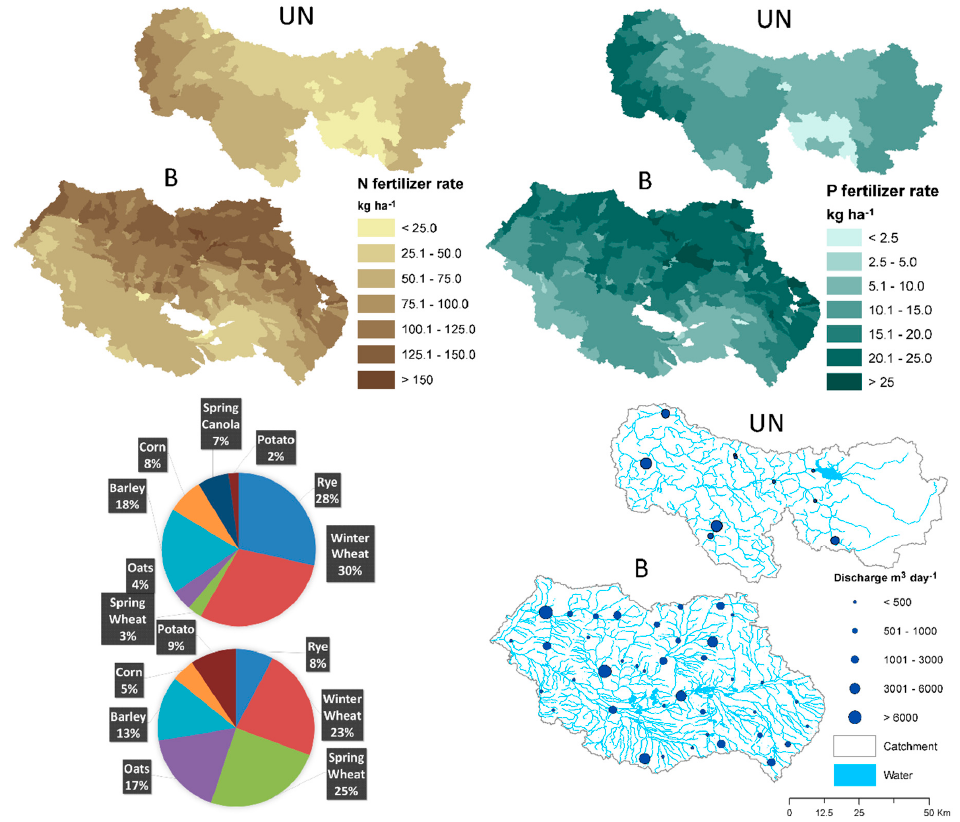
Figure 3. Spatial comparison of selected human pressure characteristics of the Upper Narew (UN) and the Barycz (B) catchment. Top panels show fertilizer rates, bottom left panel shows the crop structure and bottom right panel shows discharges from the wastewater treatment plants in both catchments.